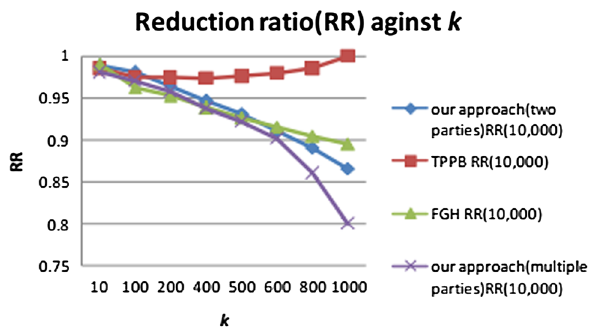
Fig. 4 RR with different values for k , dataset size = 10,000